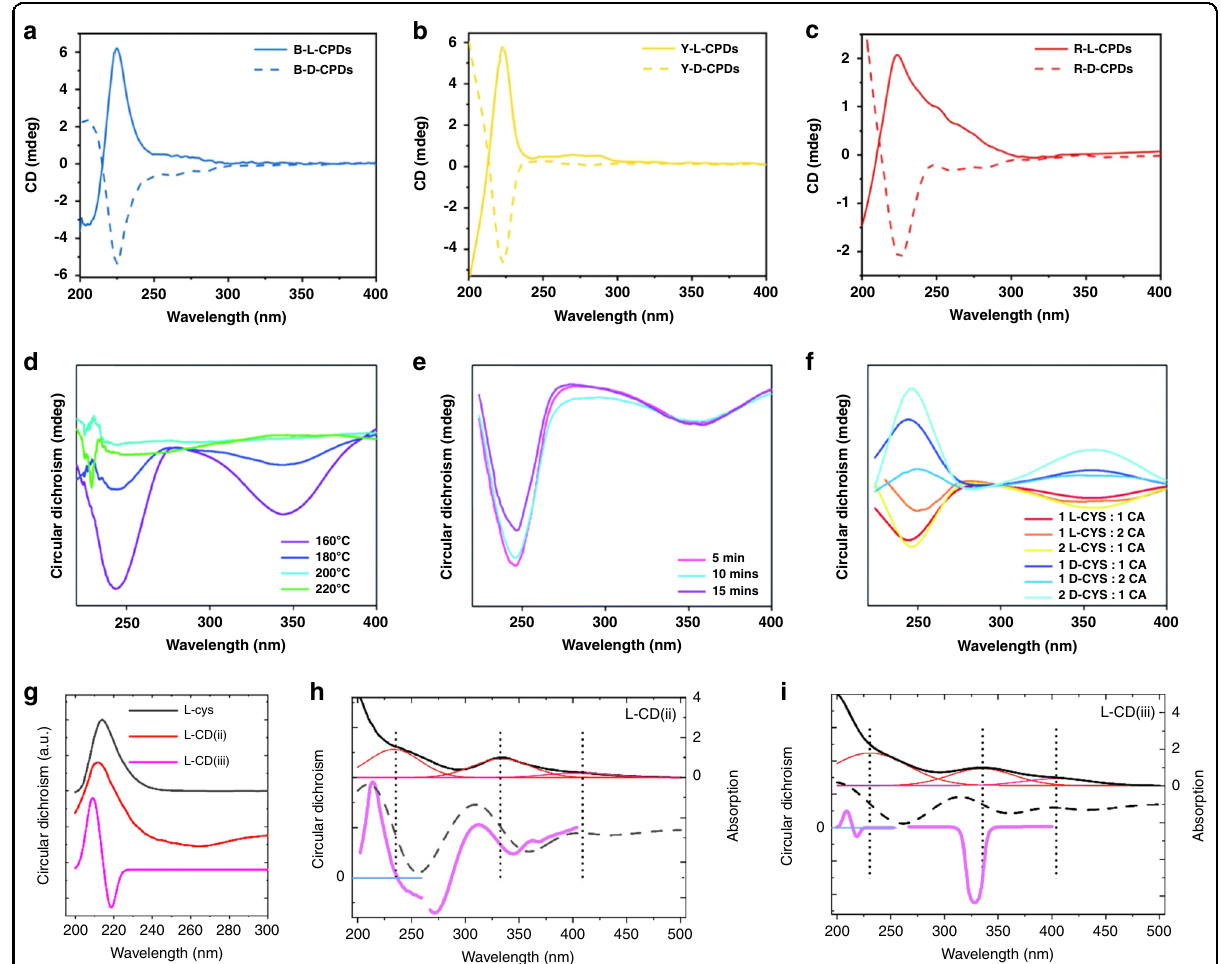
Fig. 5 Chiroptical properties of chiral carbon dots. a – c CD spectra of carbon dots synthesized from L-/D-tryptophan and phenylene diamine in different solvents, with a blue, b yellow, and c red emission. d – f CD spectra of chiral carbon dots synthesized under different synthetic conditions: d reaction temperatures, e synthesis time, f precursor ratios between L-/D-cysteine and citric acid. g – i CD spectra of carbon dots synthesized from citric acid, urea, and L-cysteine by surface treatment (the sample called L-CD (ii)), and one-pot carbonization (sample L-CD (iii)): (g) Comparison of CD spectra of L-cysteine (L-cys, black line), L-CD (ii) (red line), and L-CD (iii) (pink line); h, i Absorption (black and red lines), its fi rst derivative (black dashed lines) and circular dichroism spectra (pink lines) of L-CD (ii) ( h ) and L-CD (iii) ( i ). a – c Adapted with permission from 59 Copyright 2021